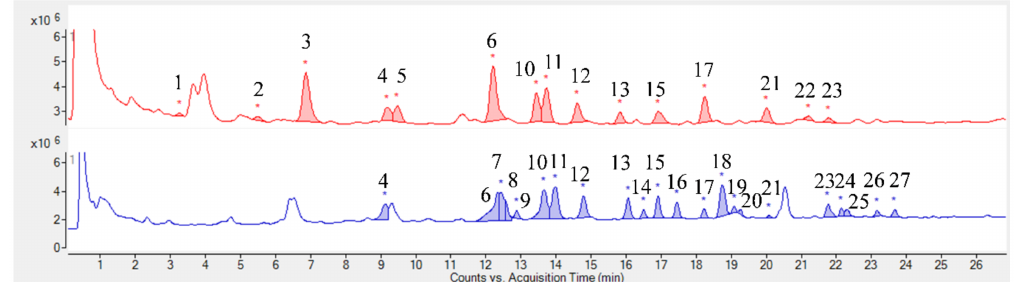
Figure 1. UHPLC-MS chromatogram of K. brasiliensis leaf juice in positive and negative mode. Red: K. brasiliensis chromatogram in positive mode; Blue: K. brasiliensis chromatogram in negative mode. The numbers represent the identified substances. * Peak integration.